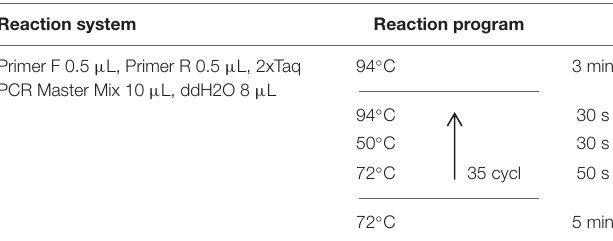
TABLE 1 | Reaction systems and PCR protocols using YGSP and SR3 primer pairs for the detection of S. reilianum in sorghum